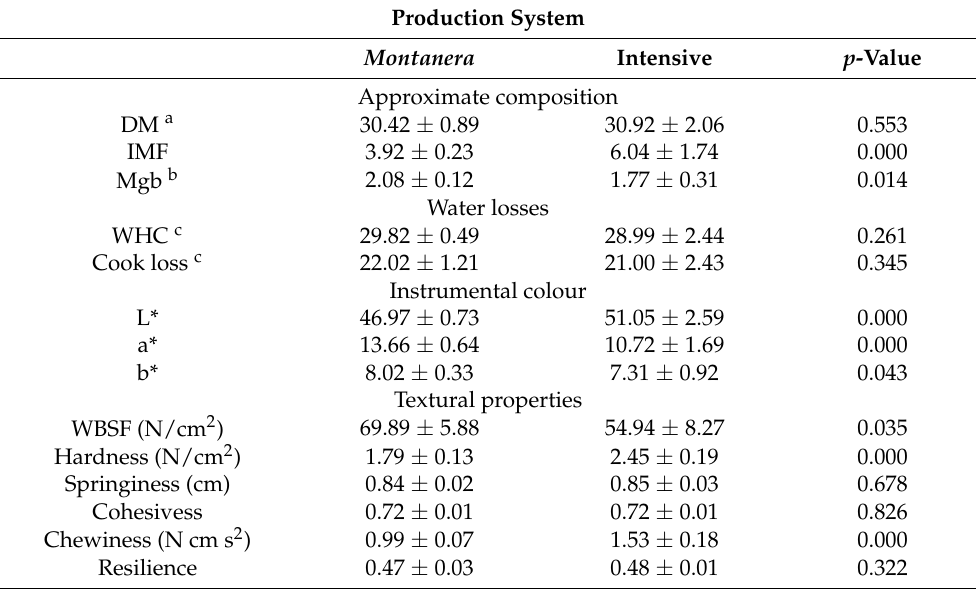
Table 7. Quality traits measured in fresh loins (m. Longissimus thoracis ) from Iberian × Duroc crossed animals according to the production